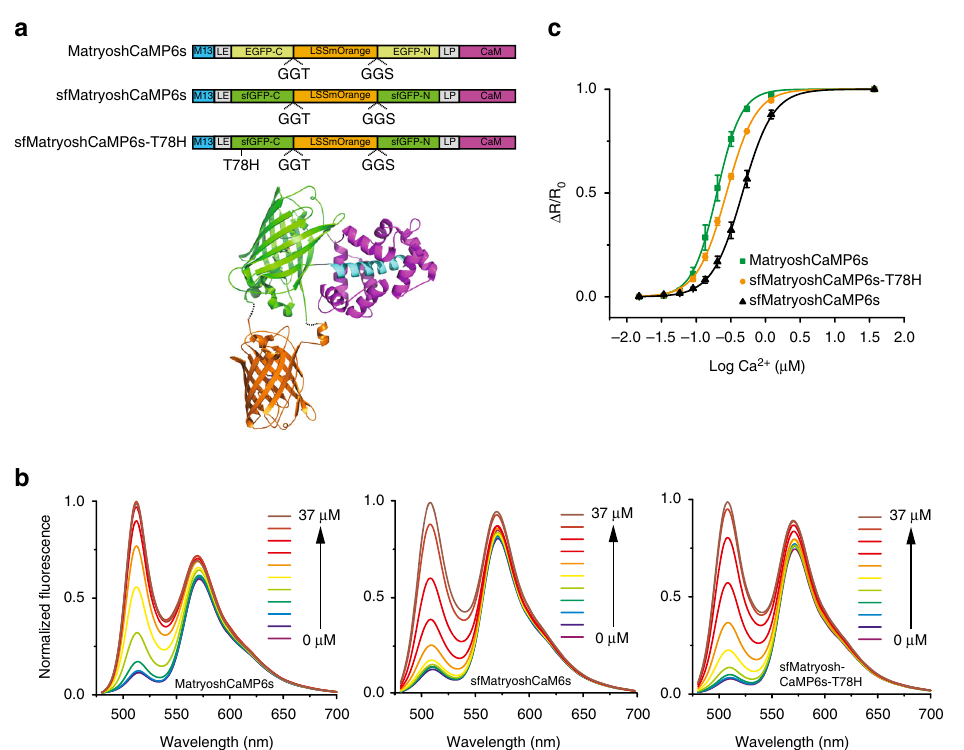
Fig. 2 In vitro characterization of MatryoshCaMP6s and sfMatryoshCaMP6s and sfMatryoshCaMP6s-T78H. a Schematic representation of MatryoshCaMP6s sensors, composed of GO-Matryoshka (LSSmOrange sandwiched between the C and N termini of either EGFP, sfGFP or sfGFP-T78H) inserted between the M13 peptide and calmodulin domain. LE and LP represent fl anking residues that connect the cpFP domains with the recognition domains. b Steady-state fl uorescence spectra ( λ exc 440 nm) of sensors titrated with free calcium (0, 0.02, 0.03, 0.06, 0.09, 0.13, 0.20, 0.31, 0.52, 1.2 and 37 µ M). The FI change in the orange channel mainly derives from fl uorescence bleed through. c Calcium-af fi nity titrations (R = FI 510nm /FI 570nm ) corresponding to the spectra in b . Data were corrected for fl uorescence bleed-through (factor 0.1; mean ± s.e.m. from biological replicates with n = 6 for MatryoshCaMP6s and sfMatryoshCaMP6s, n = 4 for sfMatryoshCaMP6s-T78H)